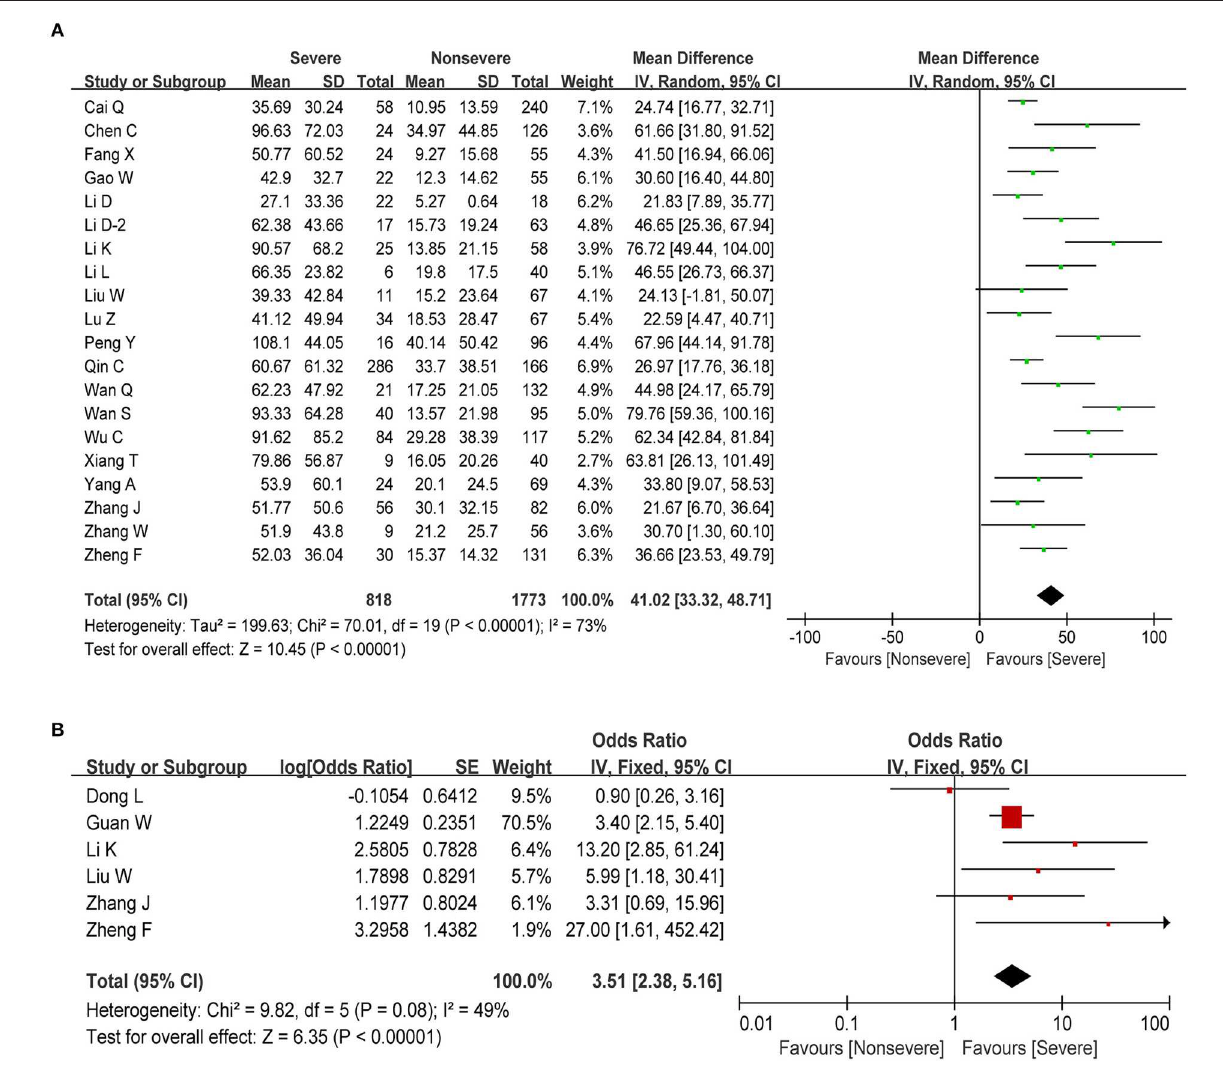
FIGURE 6 | Correlation between CRP and disease severity of COVID-19. (A) Forest plot of mean difference in CRP. (B) Forest plot of OR for the association of increased CRP with disease severity.